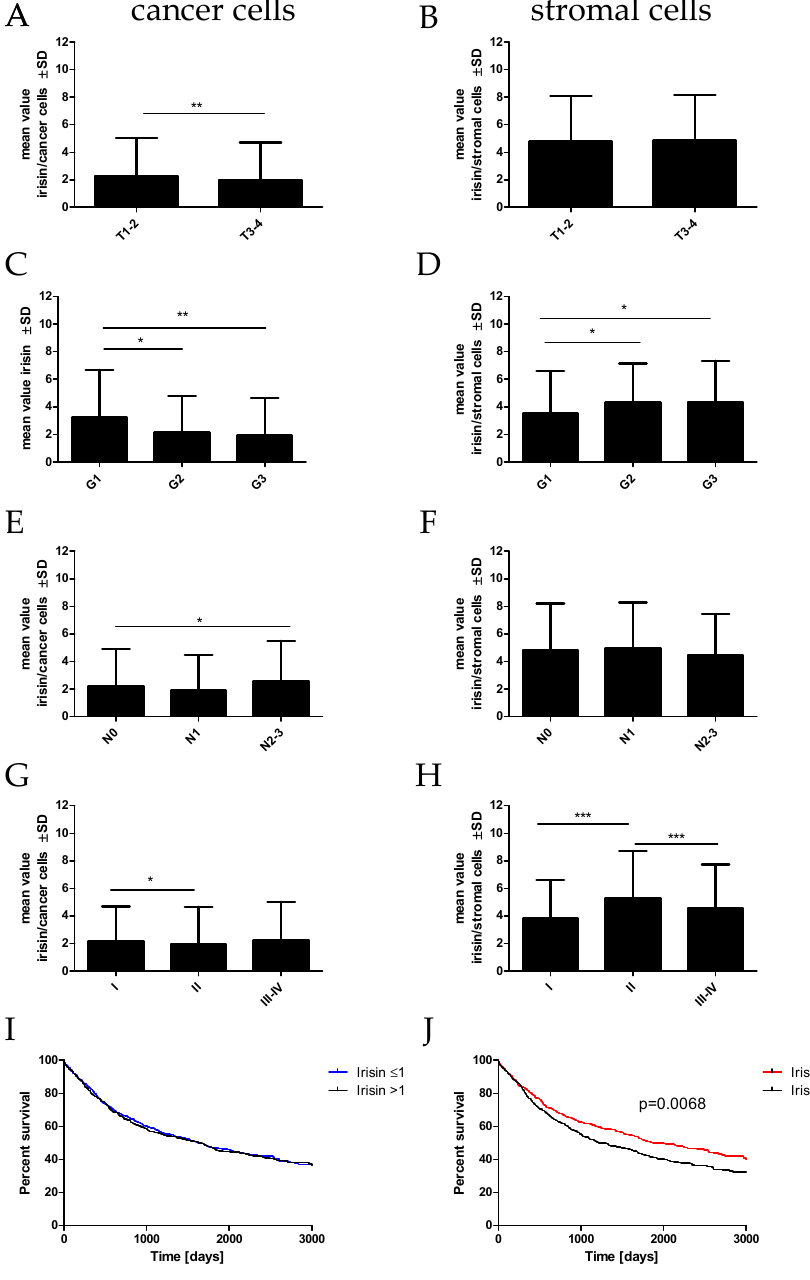
Figure 2. Comparison of irisin expression levels detected by immunohistochemistry (IHC) in NSCLC (n = 860) cells ( A , C , E , G ) and in stromal cells ( B , D , F , H ) according to the tumor size ( A , B ), malignancy grade ( C , D ), lymph node status ( E , F ), and tumor stage ( G , H ), * p ≤ 0.05, ** p ≤ 0.005, *** p ≤ 0.001. Kaplan–Meier survival curves show the prognostic impact of irisin expression levels in cancer cells ( I ) and stromal cells ( J ) on overall survival (OS) in patients with NSCLC. Patients were grouped according to the median value of expression levels.